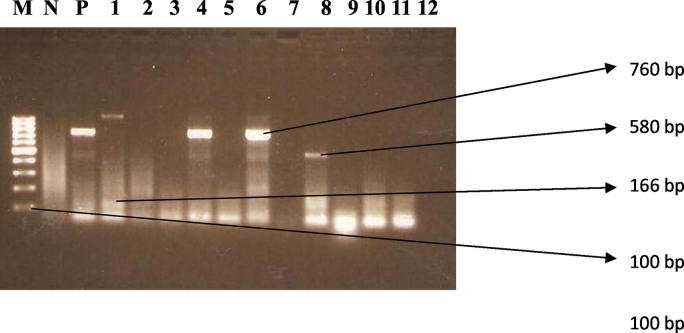
Representative images showing the agarose gel electrophoresis of the amplification of the Entamoeba DNA. The 166-, 580- and 760-bp bands depict specific amplification of DNA from E. histolytica, E. moshkovskii, or E. dispar, respectively. Lane “M” is the 100 bp ladder molecular weight maker. Lane “N” is no stool sample (negative control), P is positive control. Lanes 1–12 are representative clinical samples.